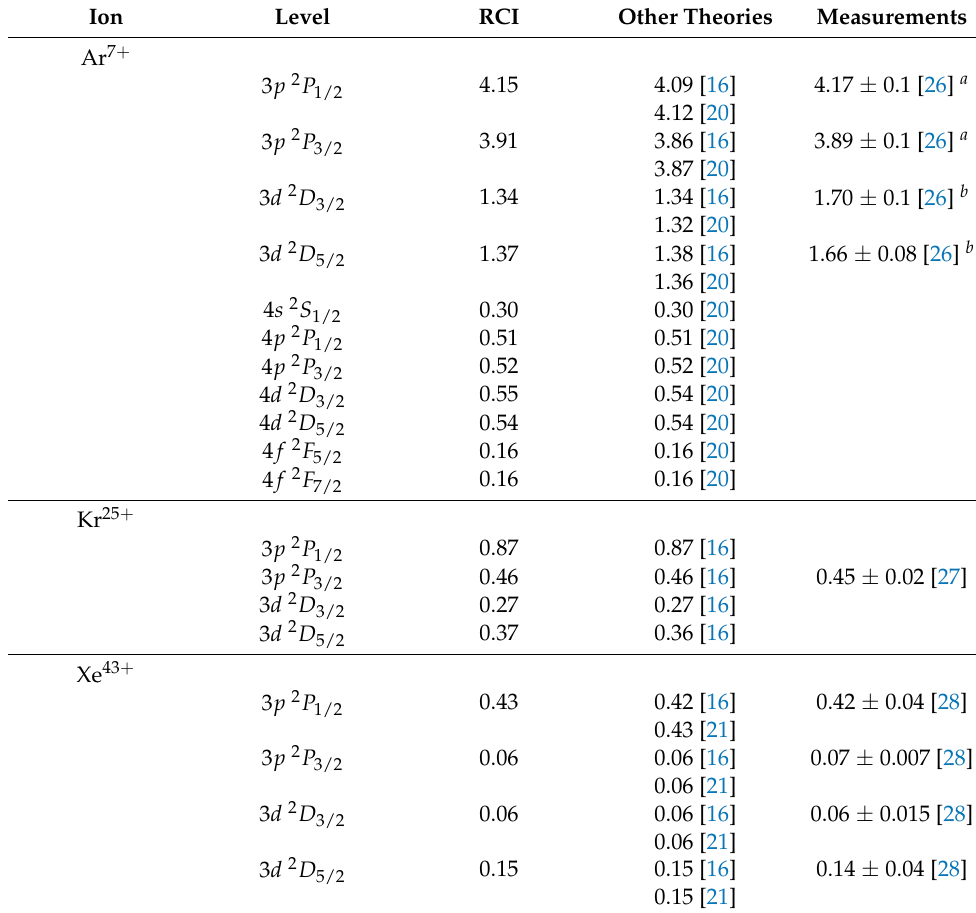
Table 6. The lifetimes (unit: 10 − 10 s) from the present work and previous studies of Theodosiou and Curtis [16] , Froese Fischer et al. [20], Vilkas et al. [21], Reistad et al. [26], Kink et al. [27] and Träbert et al. [28] for Na-like Ar 7 + , Kr 25 + and Xe 43 + ions. Ion Level RCI Other Theories